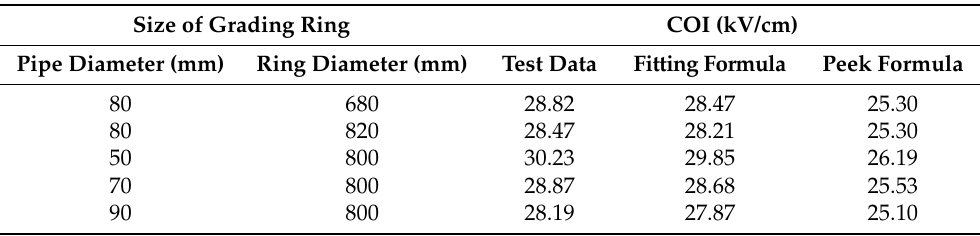
Table 4. The test data of the COI in references [17,21] and the COI calculated by fitting formula and Peek formula.